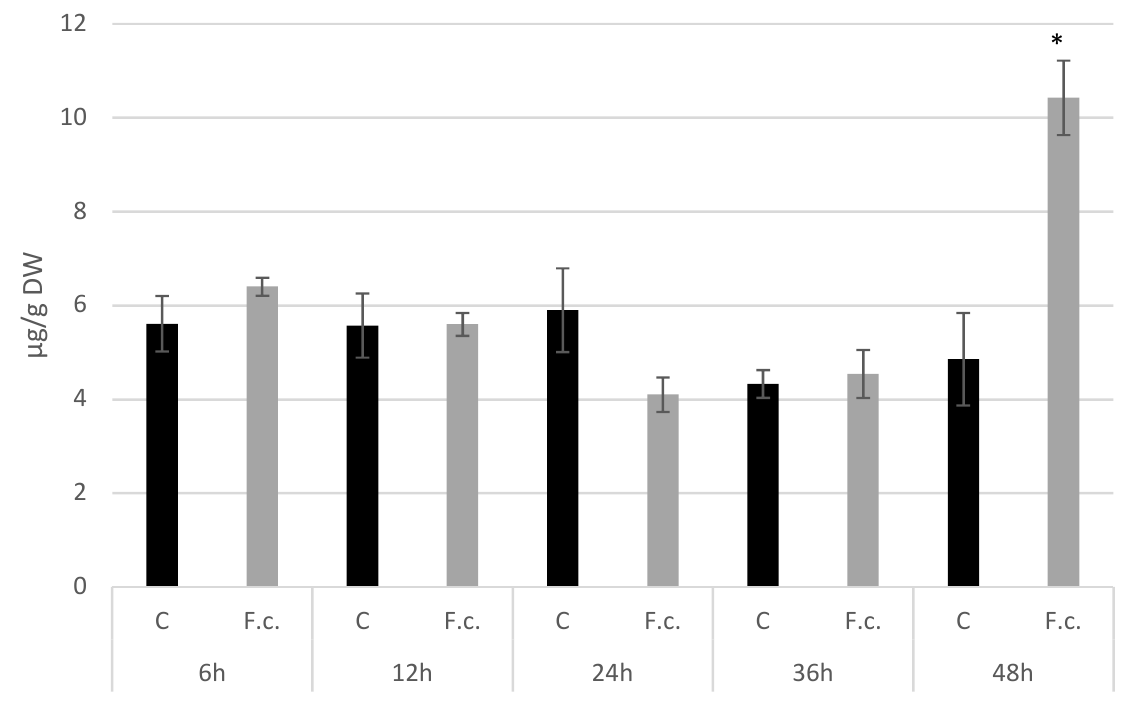
Figure 6. Amounts of callose measured in 14 days old flax seedlings infected with F. culmorum at 6 hpi, 12 hpi, 24 hpi, 36 hpi and 48 hpi. C—untreated control, Fc— Fusarium culmorum treated. Results are presented as means of three biological repeats ± sd. Statistically significant changes are marked with asterisks.